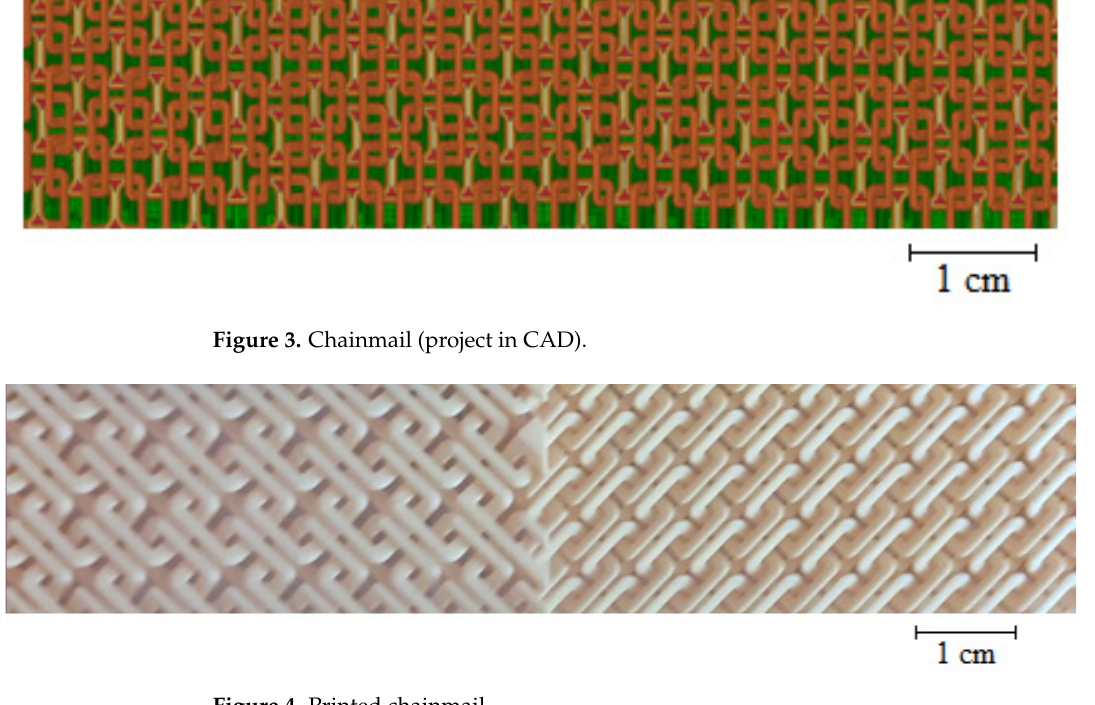
Figure 4. Printed chainmail. Figure 4. Printed